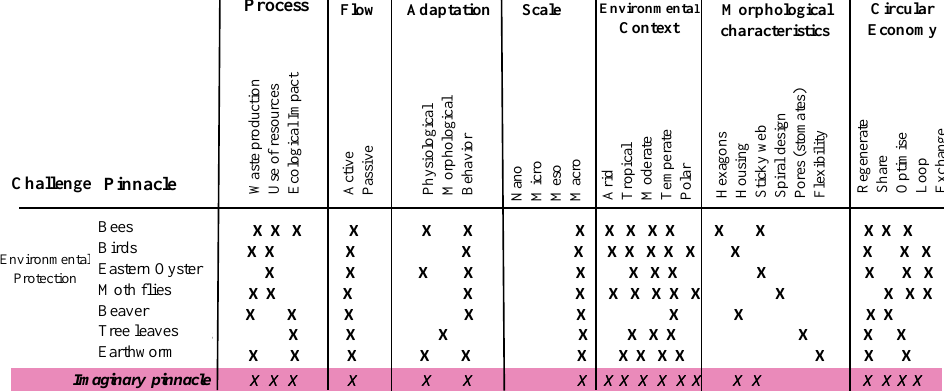
Figure 6. Pinnacle matrix analysis for the environmental protection challenge.